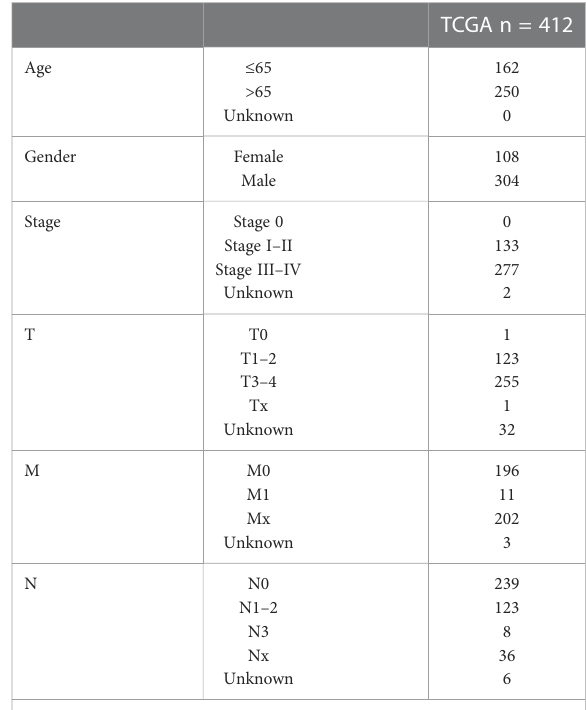
TABLE 1 Clinical information of BLCA patients from